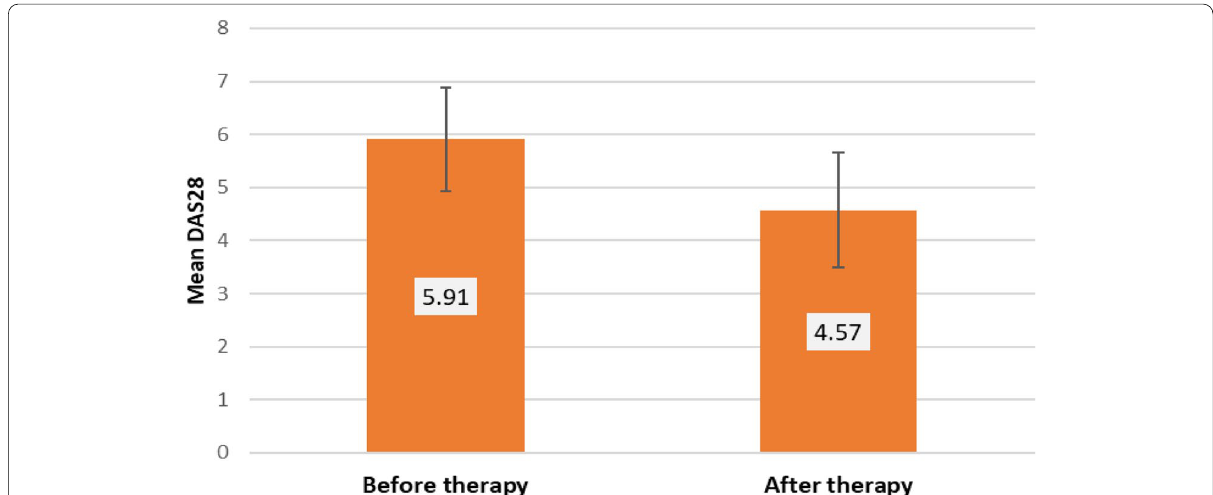
Fig. 3 Disease activity score 28 (DAS28) among the enrolled rheumatoid arthritis patients. There was a statistically significant decline in the mean DAS28 amongst RA patients from 5.91